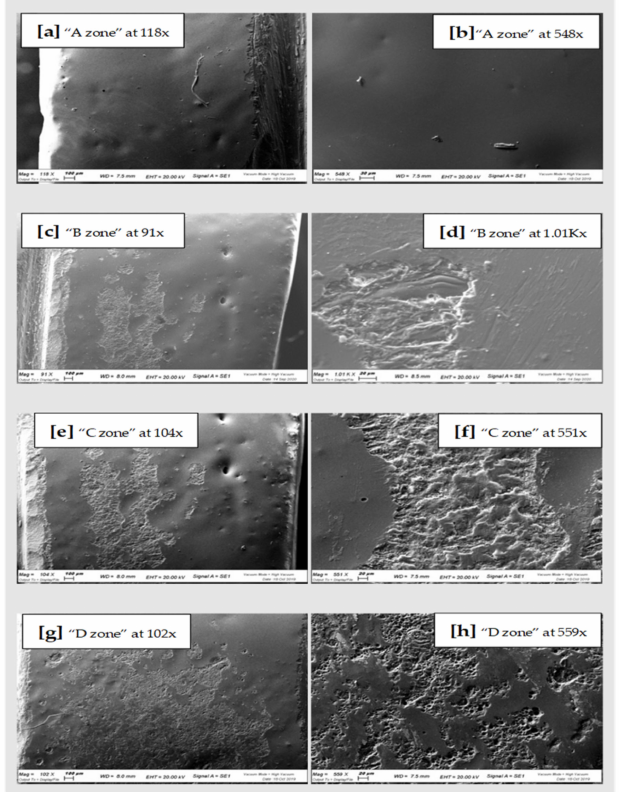
Figure 4. On the right SEM scans of pressed Lithium Disilicate “A zone” ( a , b ), “B zone” ( c , d ); “C zone” ( e , f ) and “D zone” ( g , h